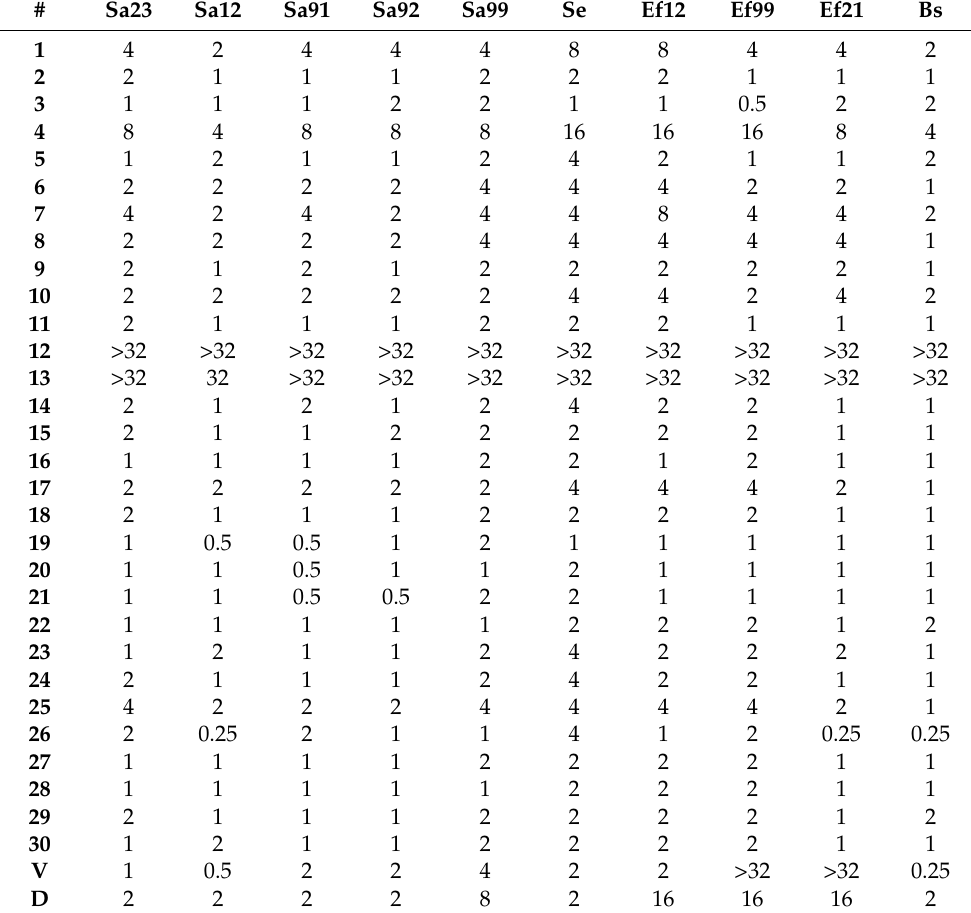
Table 2. MIC ( µ g/mL) data of the synthesized compounds. Gram-positive: Antibiotic susceptible S. aureus ATCC 25923 (Sa23), antibiotic-resistant (methicillin-resistant) strains: S. aureus BAA-2312 (Sa12), S. aureus ATCC 33591 (Sa91), S. aureus ATCC 33592 (Sa92), and S. aureus ATCC 700699 (Sa99); S. epidermidis ATCC 700296 (Se), antibiotic susceptible E. faecalis ATCC 29212 (Ef12), antibiotic- resistant (vancomycin-resistant, VRE) E. faecalis ATCC 51299 (Ef99), antibiotic-resistant